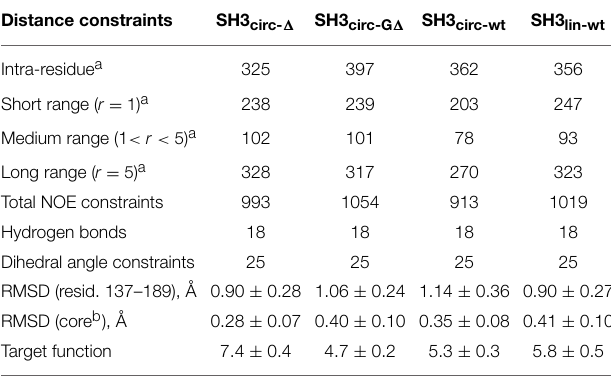
TABLE 2 | Statistics of the NOE distance constraints used for the structure calculations and of the calculated ensembles of 20 lowest-target-function structures, for each protein